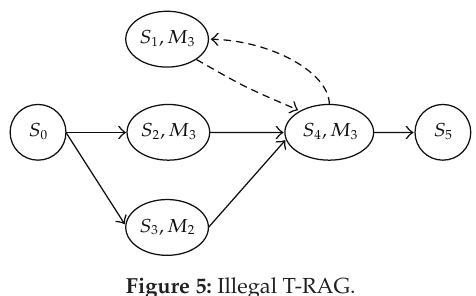
Figure 5: Illegal